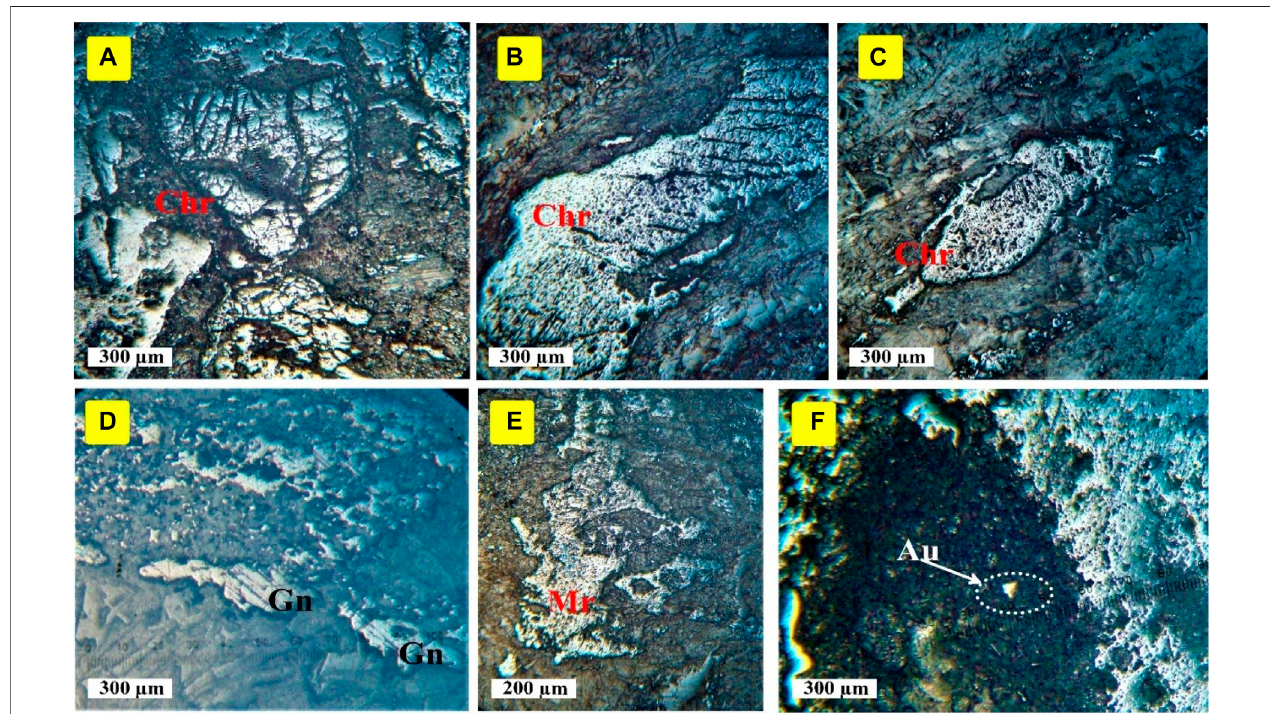
FIGURE 14 | Photomicrograph of the polished surface showing: (A) chromite, serpentinites, R. L. (B) Irregular fractured crystals of homogeneous chromite, serpentinites,R.L. (C) Chromite,serpentinites,R.L. (D) Fine-grainedgalena,serpentinites,R.L. (E) Magnetitegraincompletelyalteredtomartite,serpentinites,R.L. (F) Gold nugget coexists with quartz-carbonate, listwaenite, R. L.